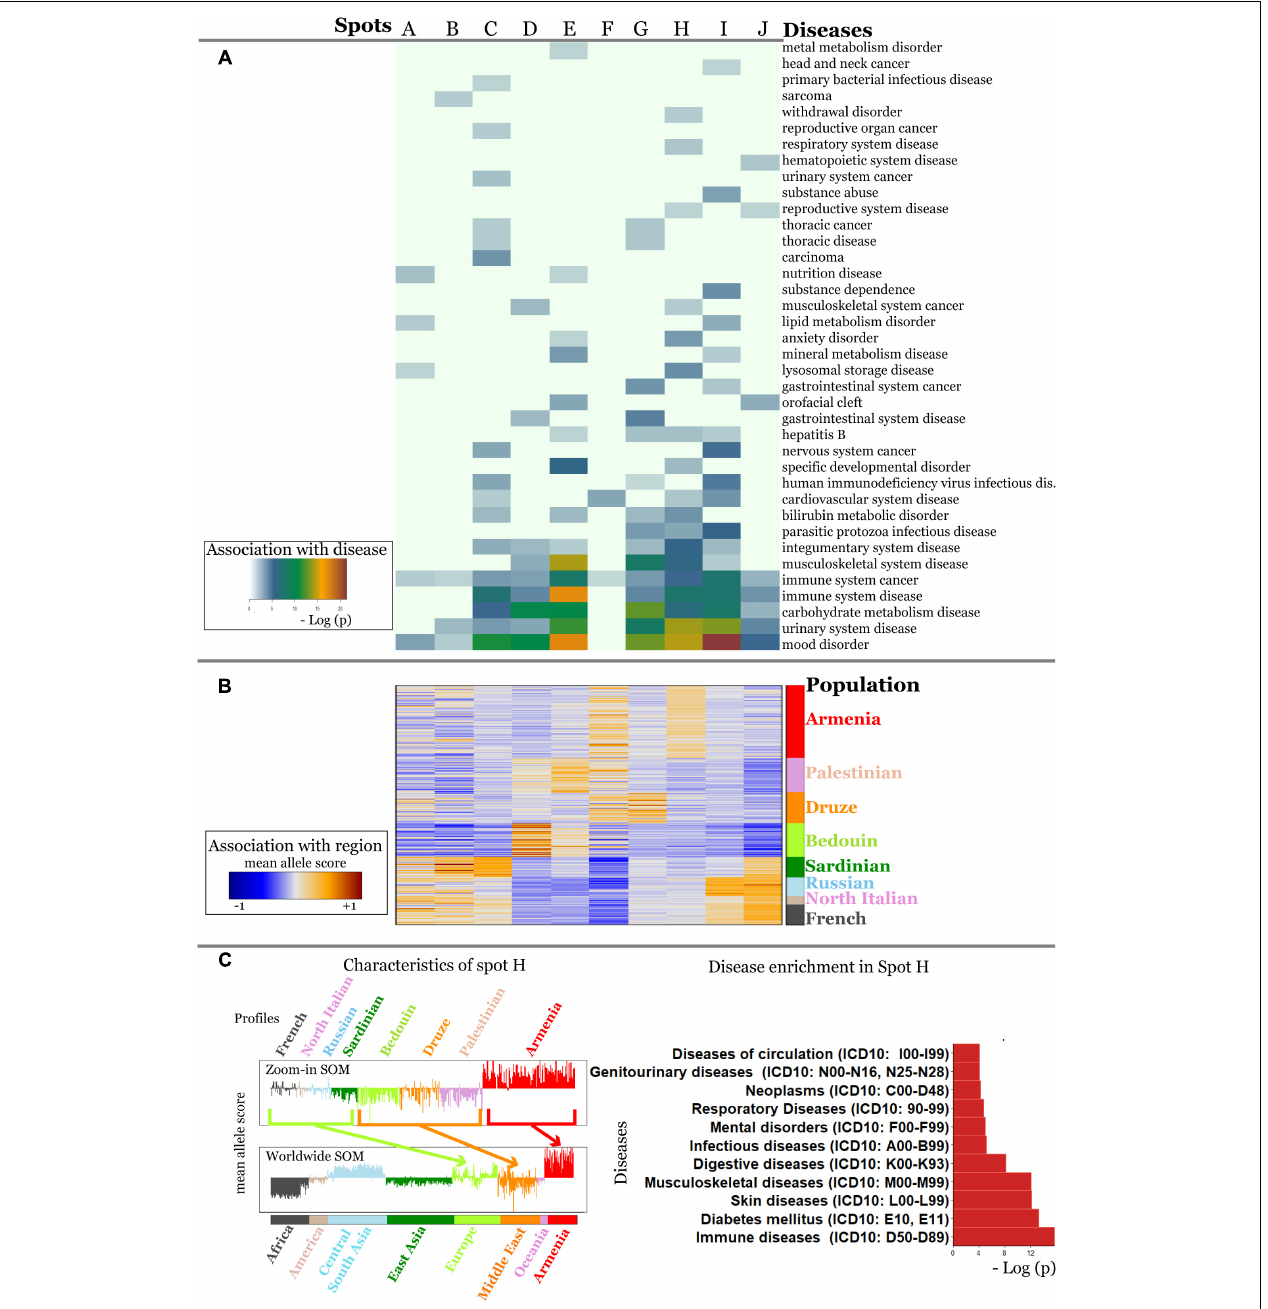
FIGURE 7 | Zoom-in analysis of selected populations from Europe and Middle East and of Armenians resolve geographic specifics of association between SNPs and disease risks with higher resolution. (A) Spot enrichment of diseases and (B) of minor allele scores are shown as heatmaps. Notably, spot H collects SNPs which suggest specifically increased disease risks in Armenians. (C) Profiles of spot H in the zoom-in and the world-wide SOM indicate specifically increased MAF of the included SNPs for Armenians. Top diseases which associate with spot H are shown as barplot of enrichment p